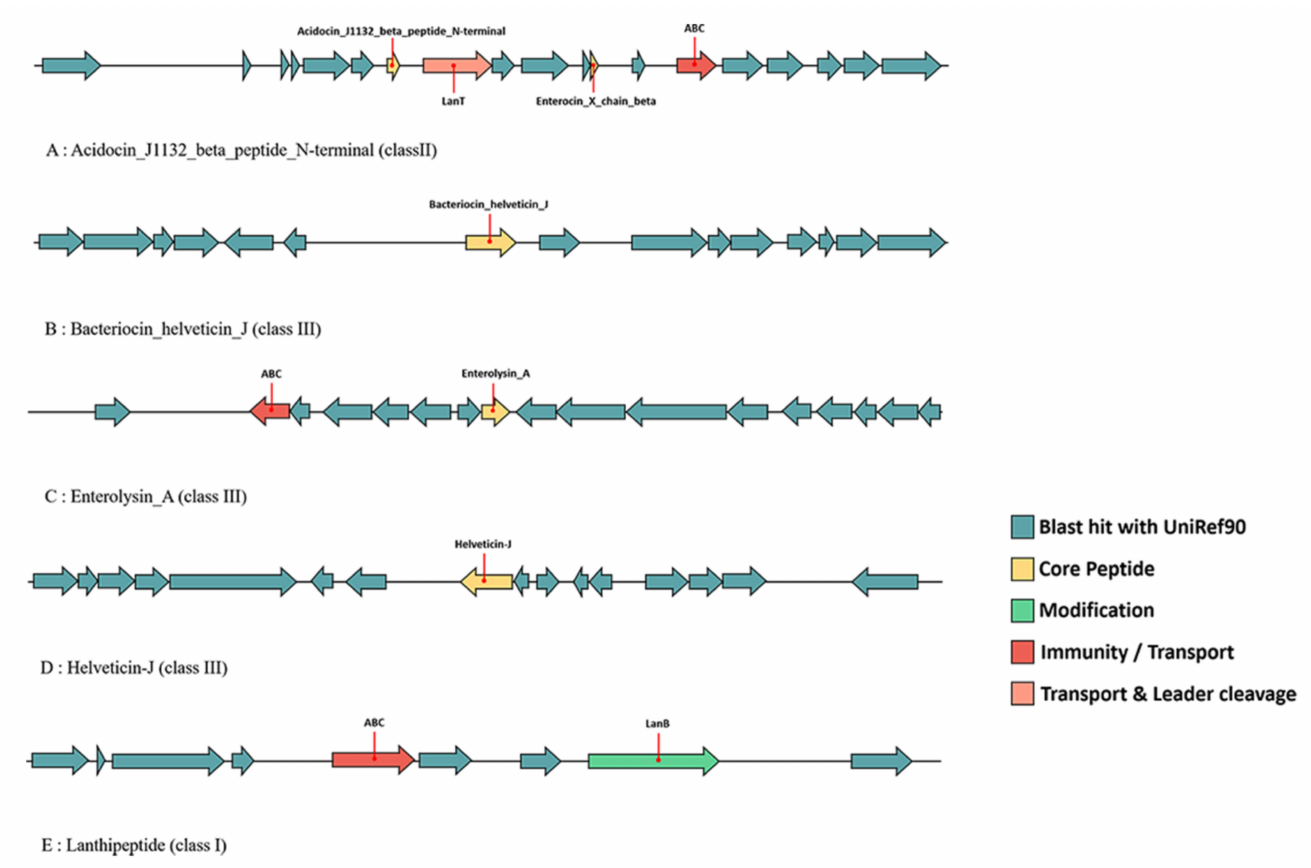
Figure 12. Predicted bacteriocin gene operon in L. acidophilus